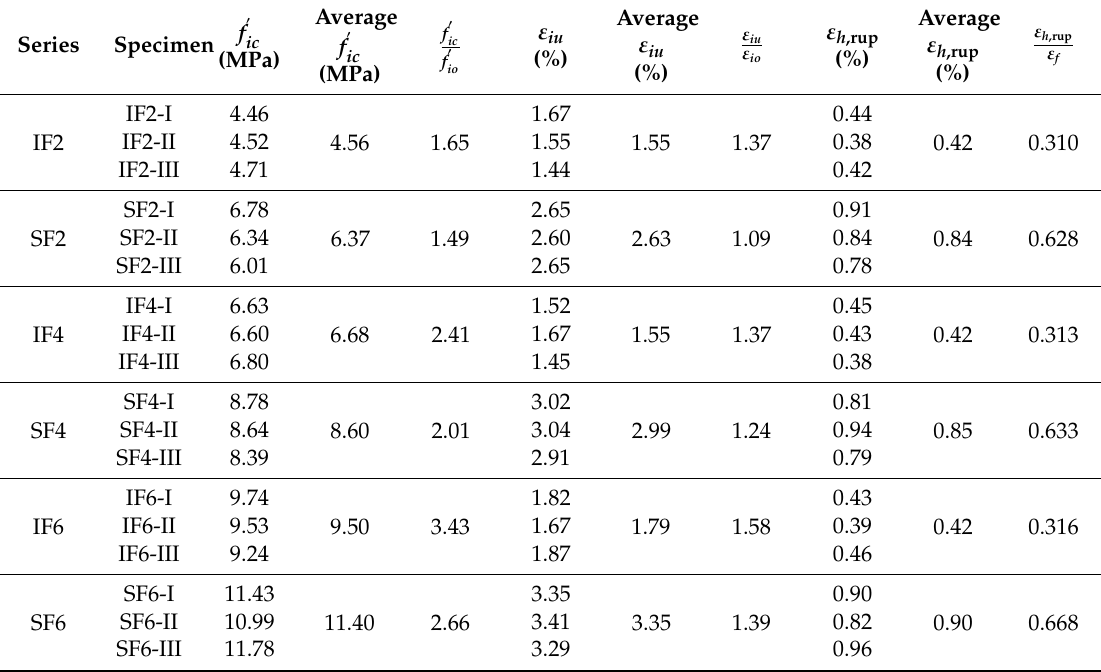
Table 2. Test results of confined plain ice and sawdust-reinforced